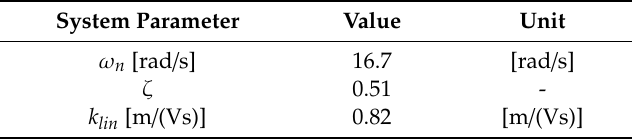
Table 1. Identified system parameters.